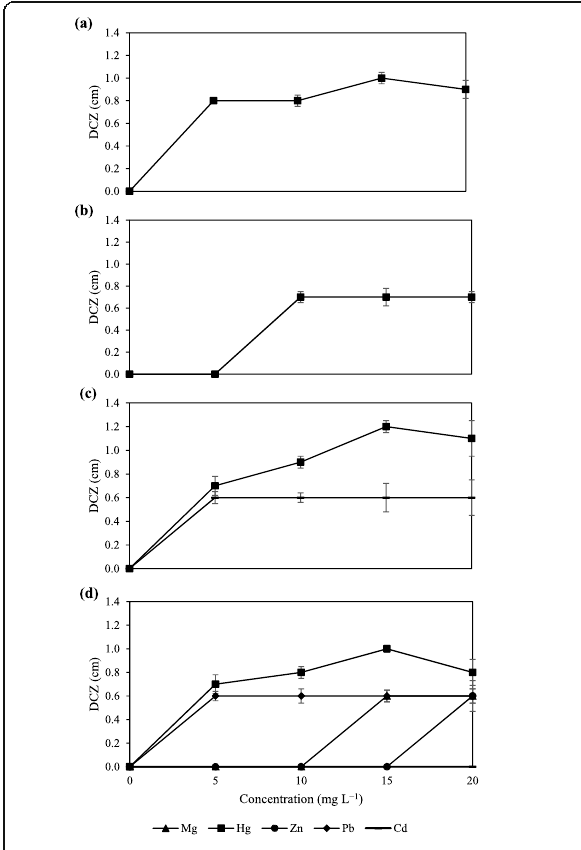
Fig. 1 DCZ values of a V. damsel , b P. aeruginosa , c P. stutzeri , and d P.